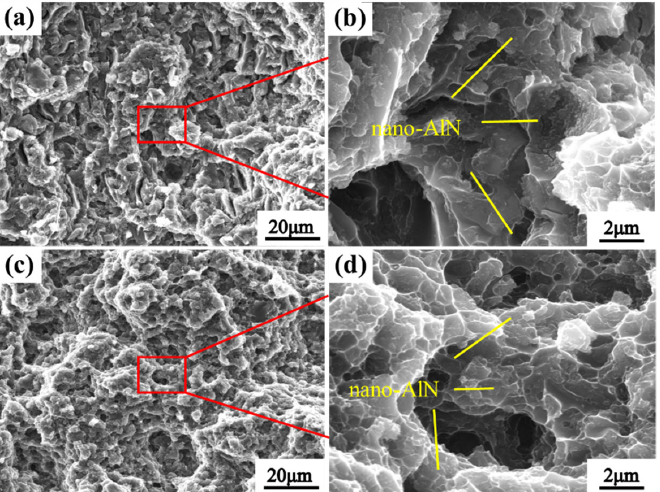
Figure 11. Fracture surface of nano ‐ AlN/Al composites: ( a , b ) As ‐ cast; ( c , d ) After HE.